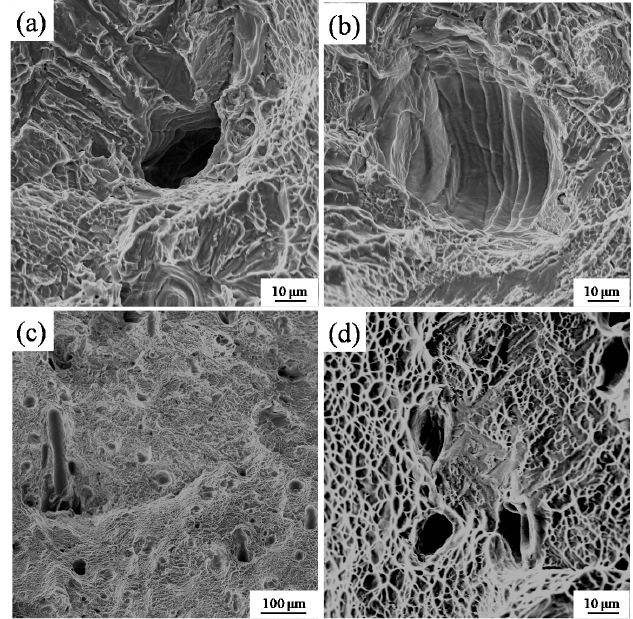
Figure 14. Scanning electron micrographs showing the defect morphologies and rupture features. ( a ) Holes; ( b ) brittle fracture; ( c ) slag inclusions; ( d ) tough fracture.